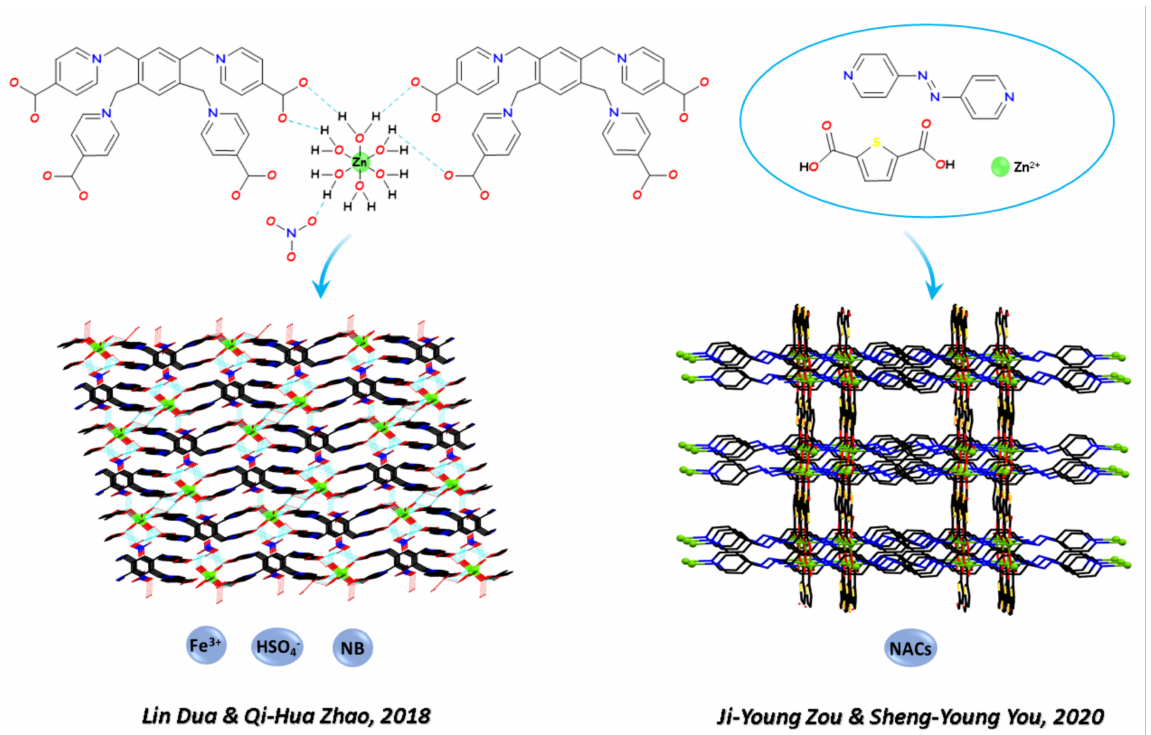
Figure 2. Some representative structures of Zn-CPs for multi-sensing of metal cations, oxyanions, and NACs metal cation sensing. Figures readapted by using Mercury software